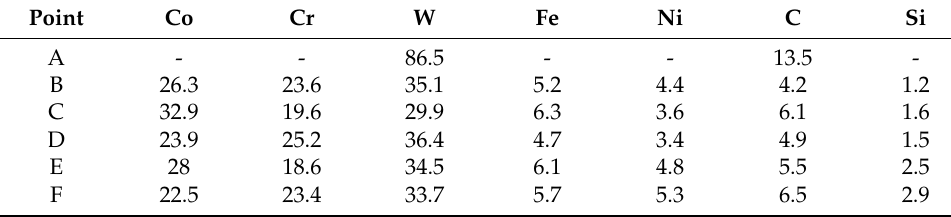
Table 2. Analysis of EDS points in the section of Co-Cr-30%WC cladding layer (wt.%).